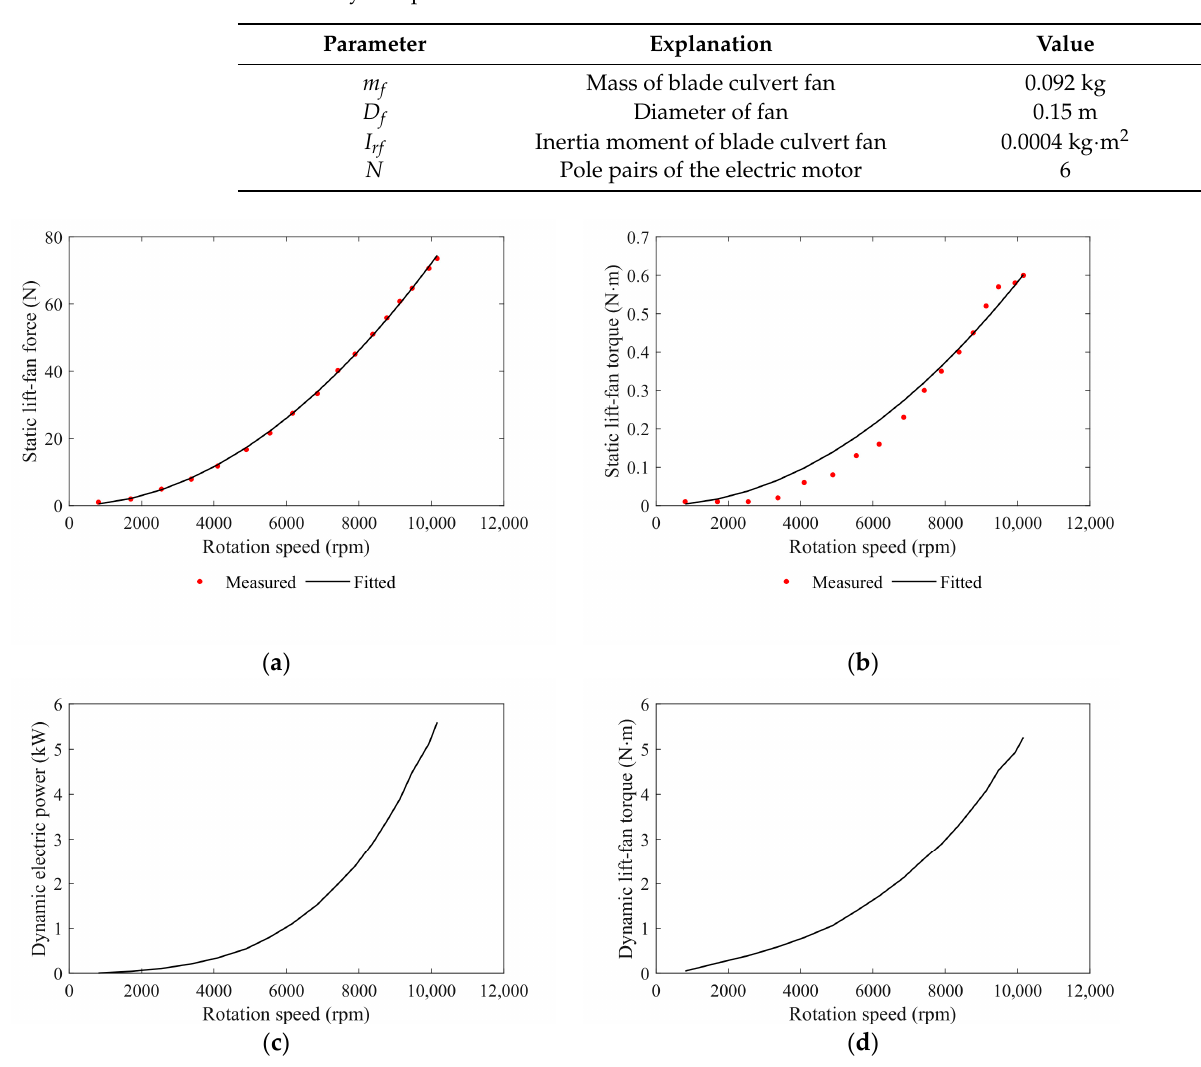
Table 2. Physical parameters of the lift fan.